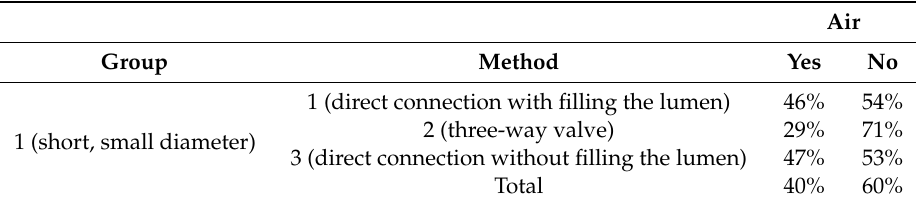
Table 5. Air in the balloons for the di ff erent